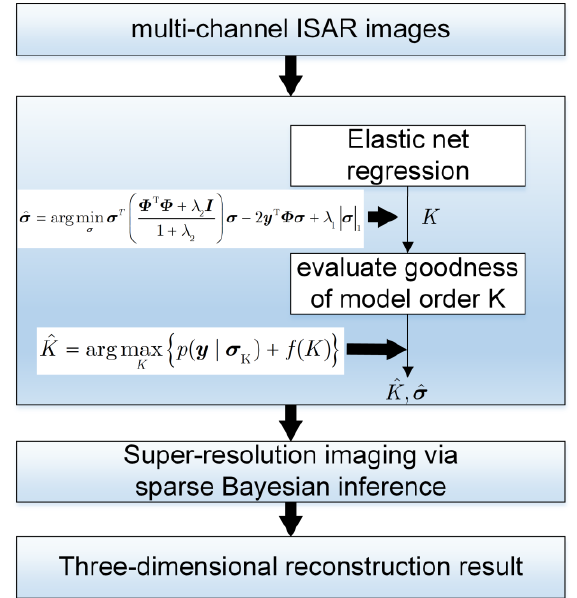
Figure 2. Flowchart of proposed array ISAR 3D imaging method.